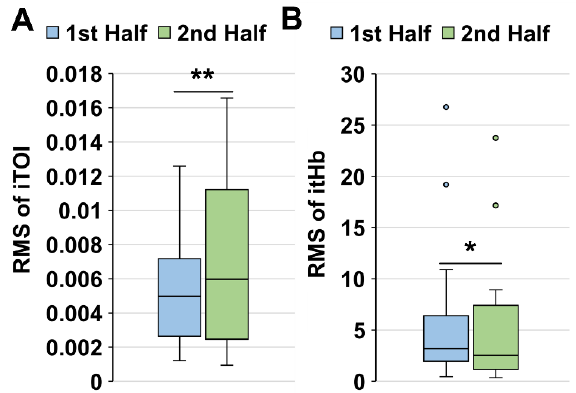
Figure 3. Comparison of the root-mean-square (RMS) values between the first half and the second half of the exercise phase of the TOI ( A ) and ΔtHb ( B ) signal. Statistical significance: * p < 0.05, ** p < 0.01.